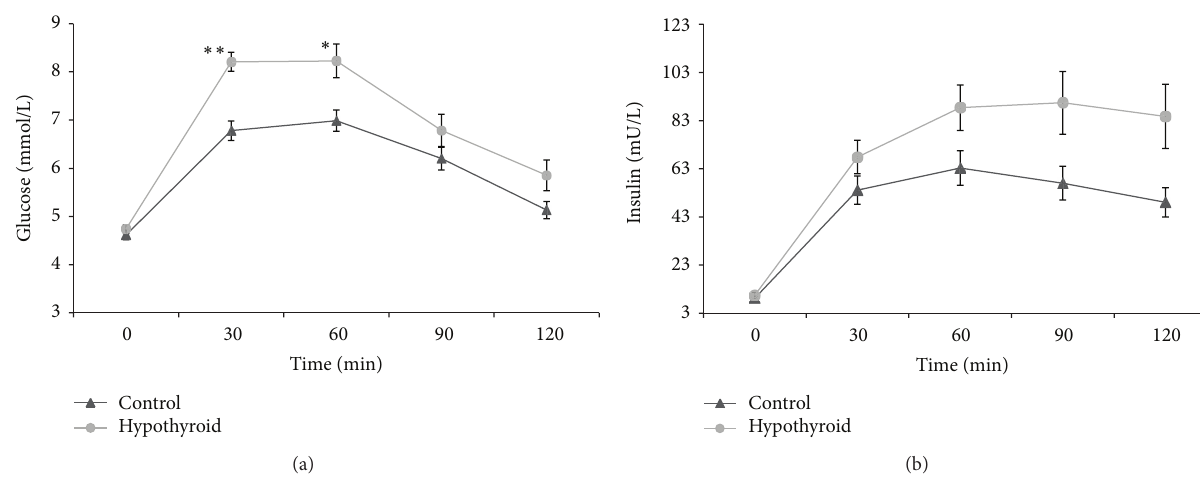
Figure 2: Mean values ± SE of fasting blood glucose and insulin and their postprandial changes in the group of hypothyroid (hypothyroid) and healthy women (control). Asterisks denote differences between these groups; ∗ 𝑃 < 0.005 ; ∗∗ 𝑃 < 0.0001 .